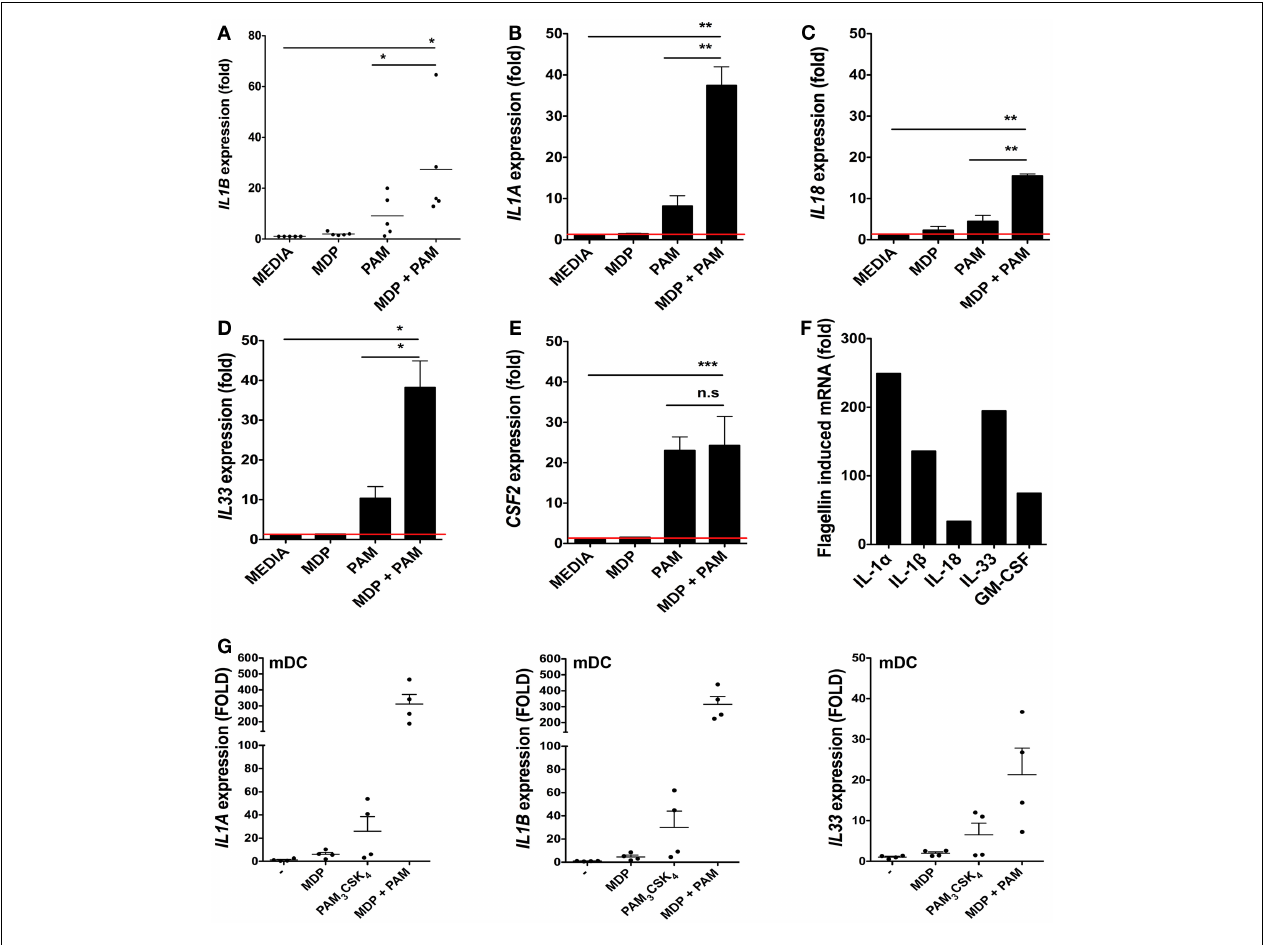
patients, (F) shows the mean induction of expression of the indicated genes by iSCs from one patient after stimulation with flagellin, representative of three experiments with similar results. (G) Shows mean fold changes ± SEM in expression of the indicated mRNA in stimulated mDCs generated from n = 4 peripheral blood donors. * p < 0.05, ** p < 0.01, *** p <